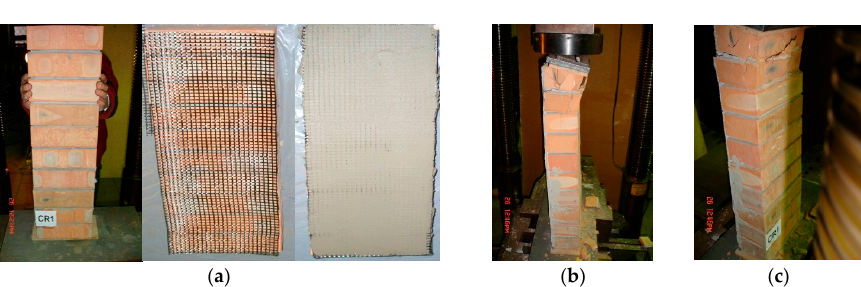
Figure 5. Masonry segment of ceramic bricks, cross-section 12 × 25 cm, reinforced with Ruredil mesh ( a ) from preparation; ( b ) under load; ( c ) destruction.